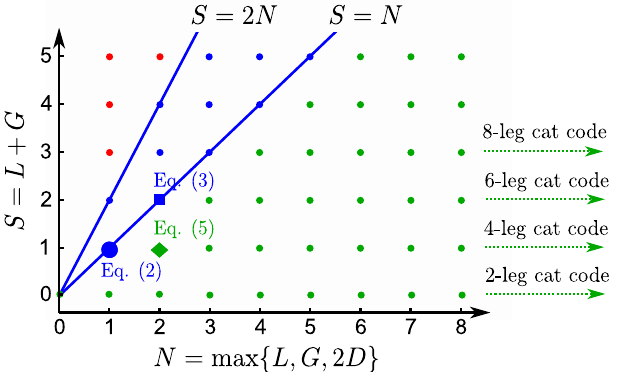
FIG. 1. Two-parameter ð N; S Þ space of the binomial codes (7). The largest blue circle denotes the code (2) protected against a photon loss error L ¼ 1 , the blue square is the code (3) protected ¯ E ¯ E 0 ˆ I; ˆ a; ˆ a 2 ; ˆ n ˆ I; ˆ a; ˆ a † ; ˆ n against g or g , and the green 2 ¼ f 2 ¼ f ¯ E 0 ˆ I; ˆ a; ˆ n diamond denotes the code (5) protected against g . 1 ¼ f The parameter S ¼ L þ G sets the total number of detectable photon loss L and gain G errors. The parameter N sets the maximum order the code is protected against photon loss, gain, and dephasing errors, N ¼ max f L; G; 2 D g . The codes denoted with blue have protection against photon loss and gain errors set by S ¼ L þ G , and in addition, they are protected against dephasing up to ˆ n ⌊ max f L;G g = 2 ⌋ . The codes denoted with red allow, in addition, heralding of S − 2 N uncorrectable photon loss or gain errors. The codes denoted with green are protected against a total of S photon loss and gain errors, as well as against up to ˆ n N= 2 dephasing errors. In the limit N → ∞ , the binomial codes asymptotically approach the 2 ð L þ 1 Þ -legged cat codes [17 – 19] protected against L photon loss